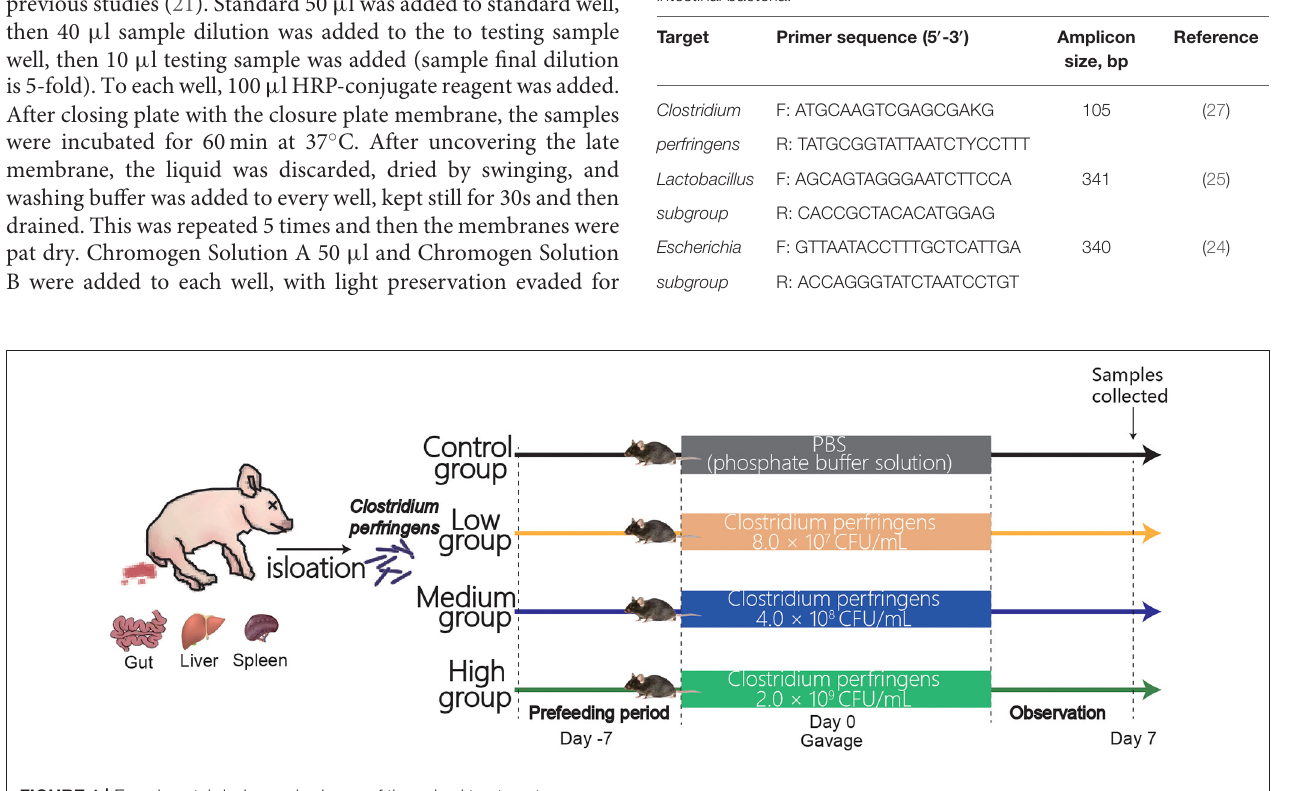
FIGURE 1 | Experimental design and scheme of the animal treatments.